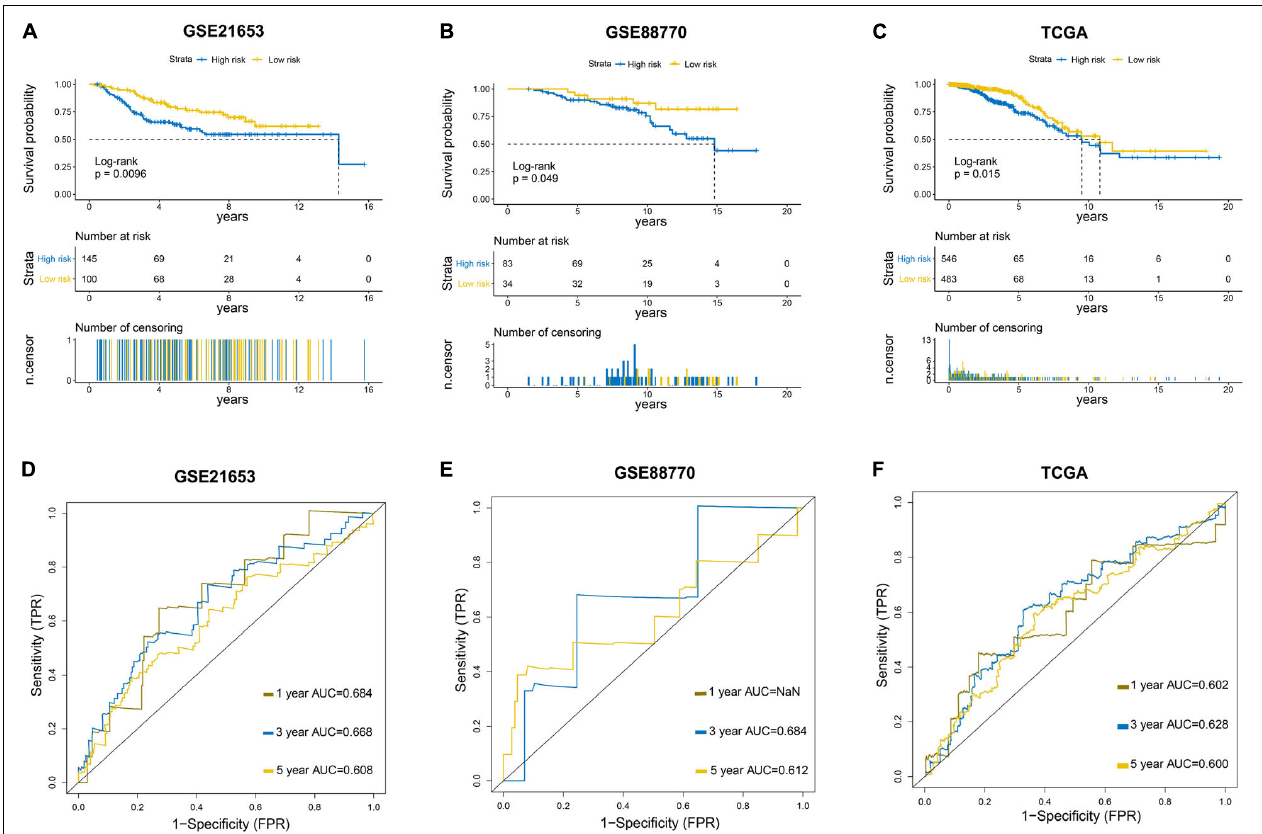
FIGURE 3 | Further evaluation of the six-LncRNA Signature in Validation Sets. (A–C) Survival curves of the prognostic signature in three validation sets. GSE21653: Disease-free survival (DFS) curve. GSE88770 and TCGA: Overall survival (OS) curve. (D–F) Survival receiver operating characteristic curves in three validation sets.